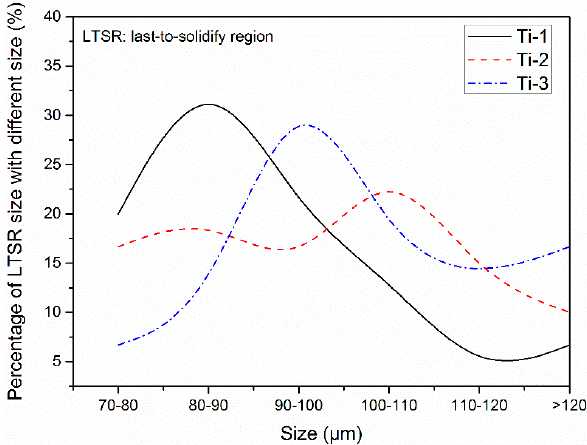
Figure 3. Variation of Ti content with the size of the last-to-solidify region.